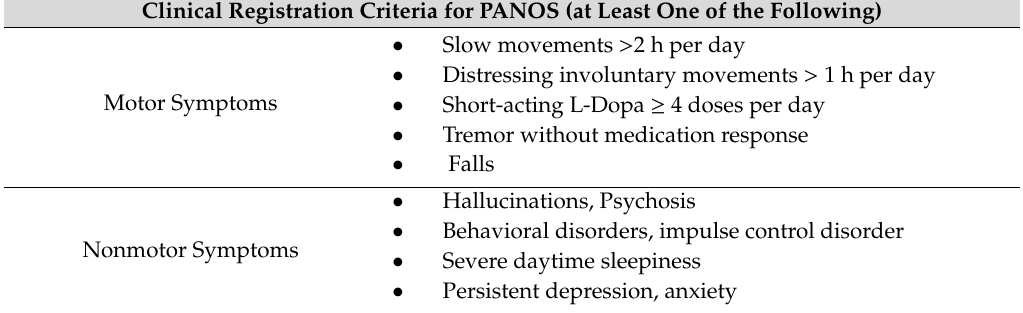
Table 3. Inclusion criteria to PANOS.